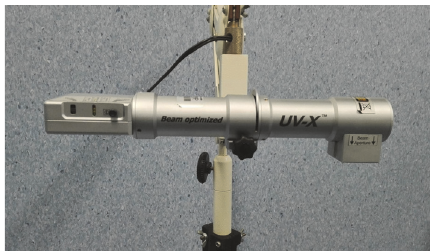
Figure 3: Cross-linking lamp used for the treatment of the patient (UV-X 2000, Avedro Inc., Waltham, United States).